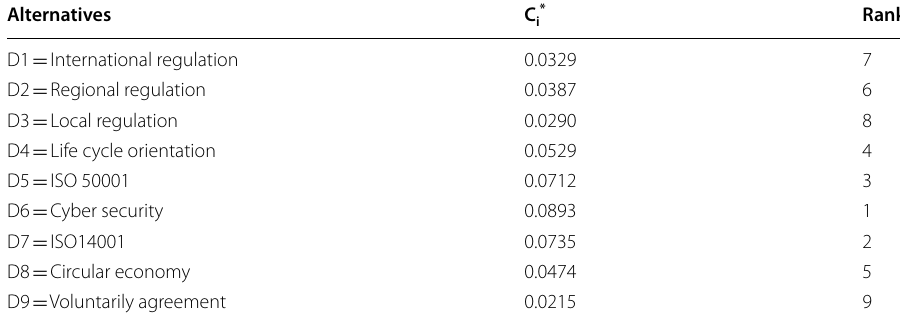
Table 23 Ranking of alternatives in policy and regulation criterion